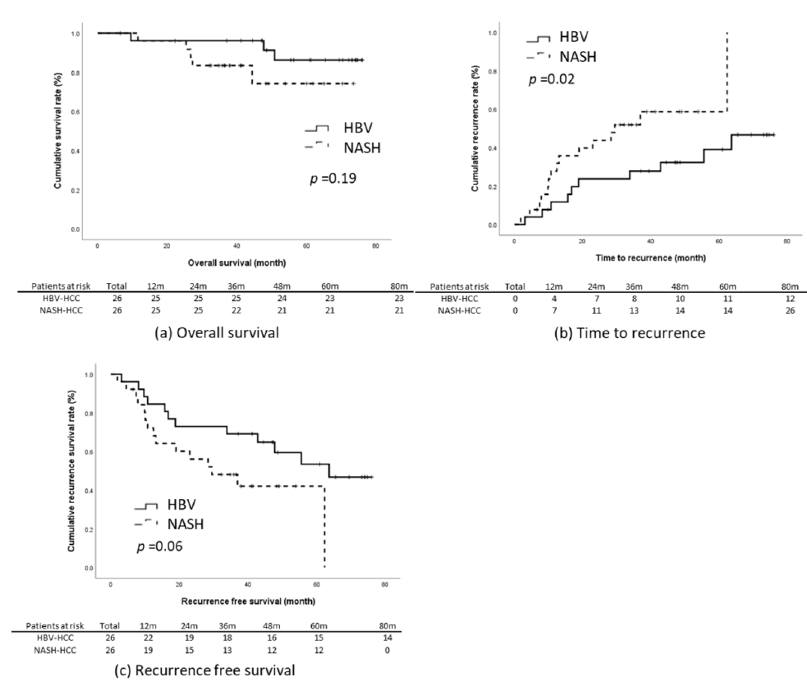
Figure 3. Outcomes in the propensity-score-matched cohort. ( a ) OS, ( b ) TTR, ( c ) RFS.